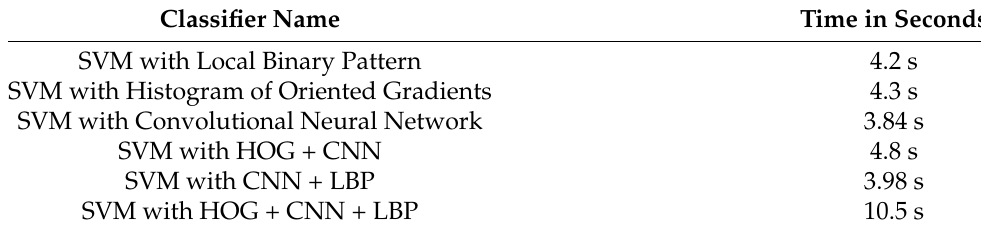
Table 2. Execution Time by SVM Classifier Using LBP, CNN and HOG.